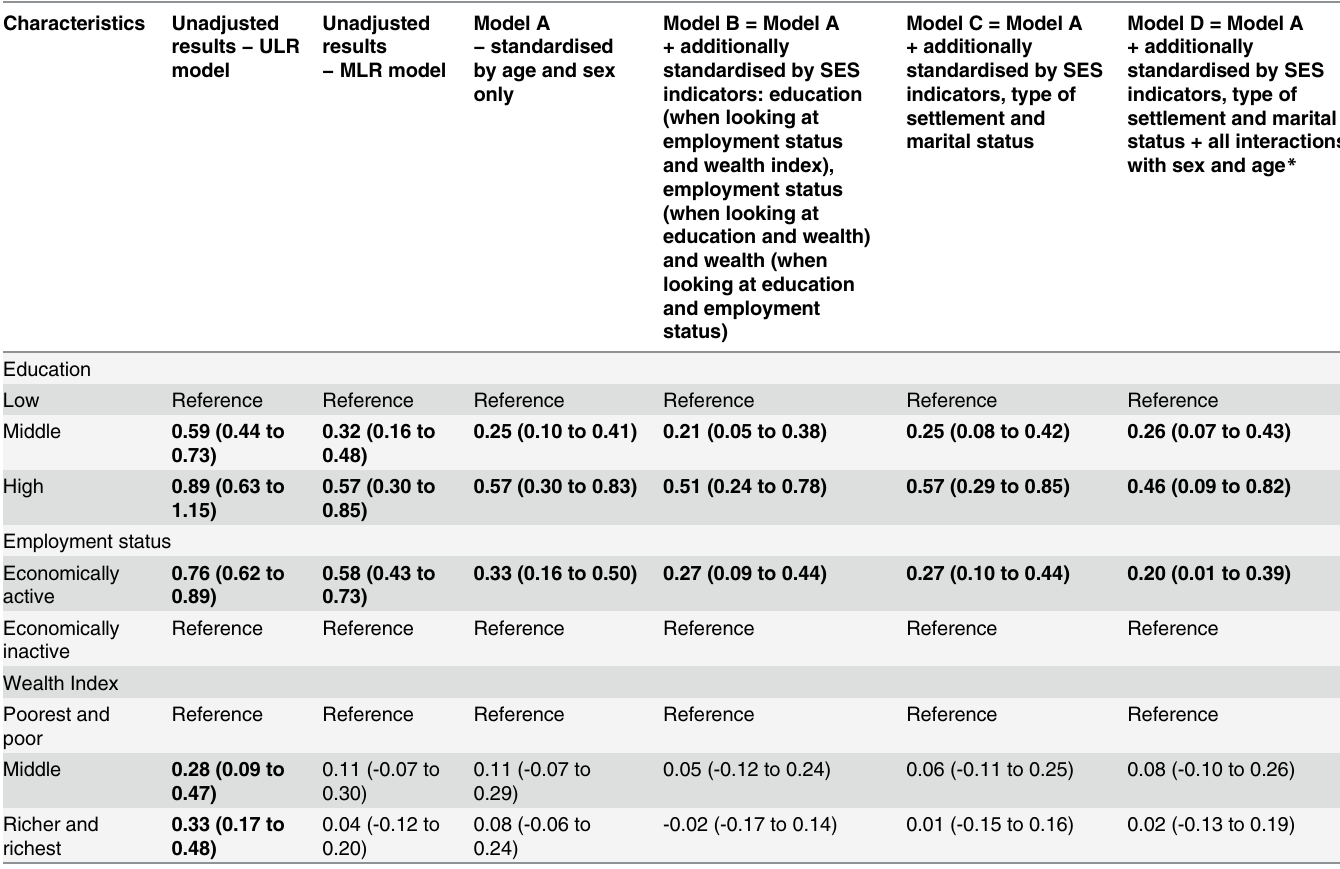
Table 4. Change in mean CVHS among health survey participants by SES indicators in models variously